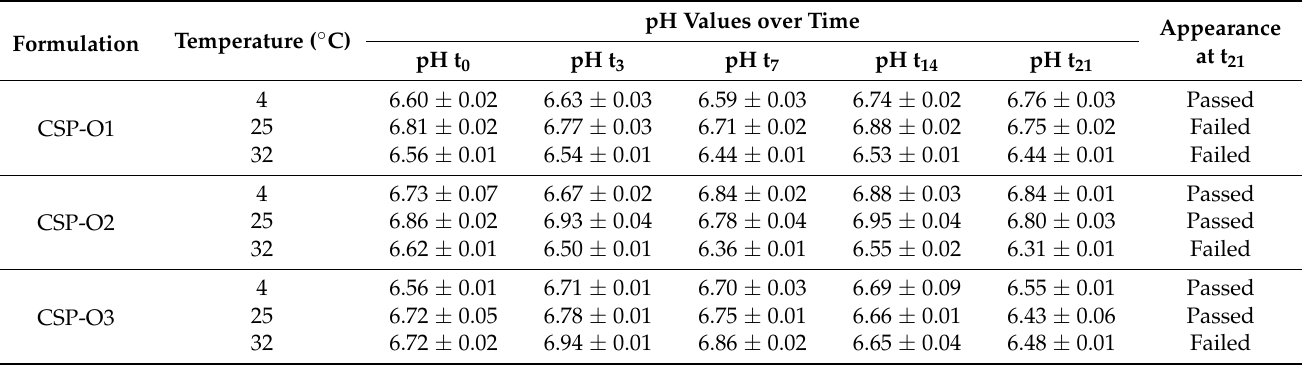
Table 1. pH values in formulations freshly prepared (t 0 ) and after three weeks (t 21 ), stored at 4, 25, and 37 ◦ C, and their visual appearance. Values represent the mean ± SD ( n = 3). pH Values over Time Appearance Formulation Temperature ( ◦ C)